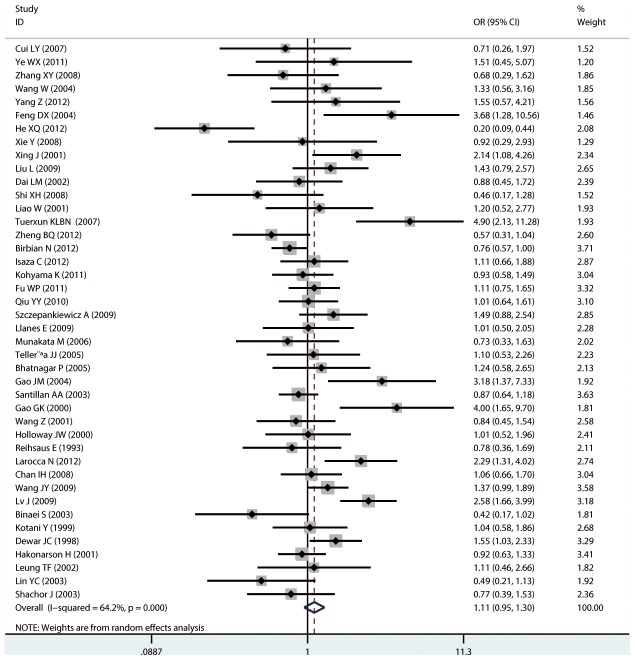
Forest plots of the association between the Arg16Gly (rs1042713) polymorphism and risk of asthma in recessive model comparison.